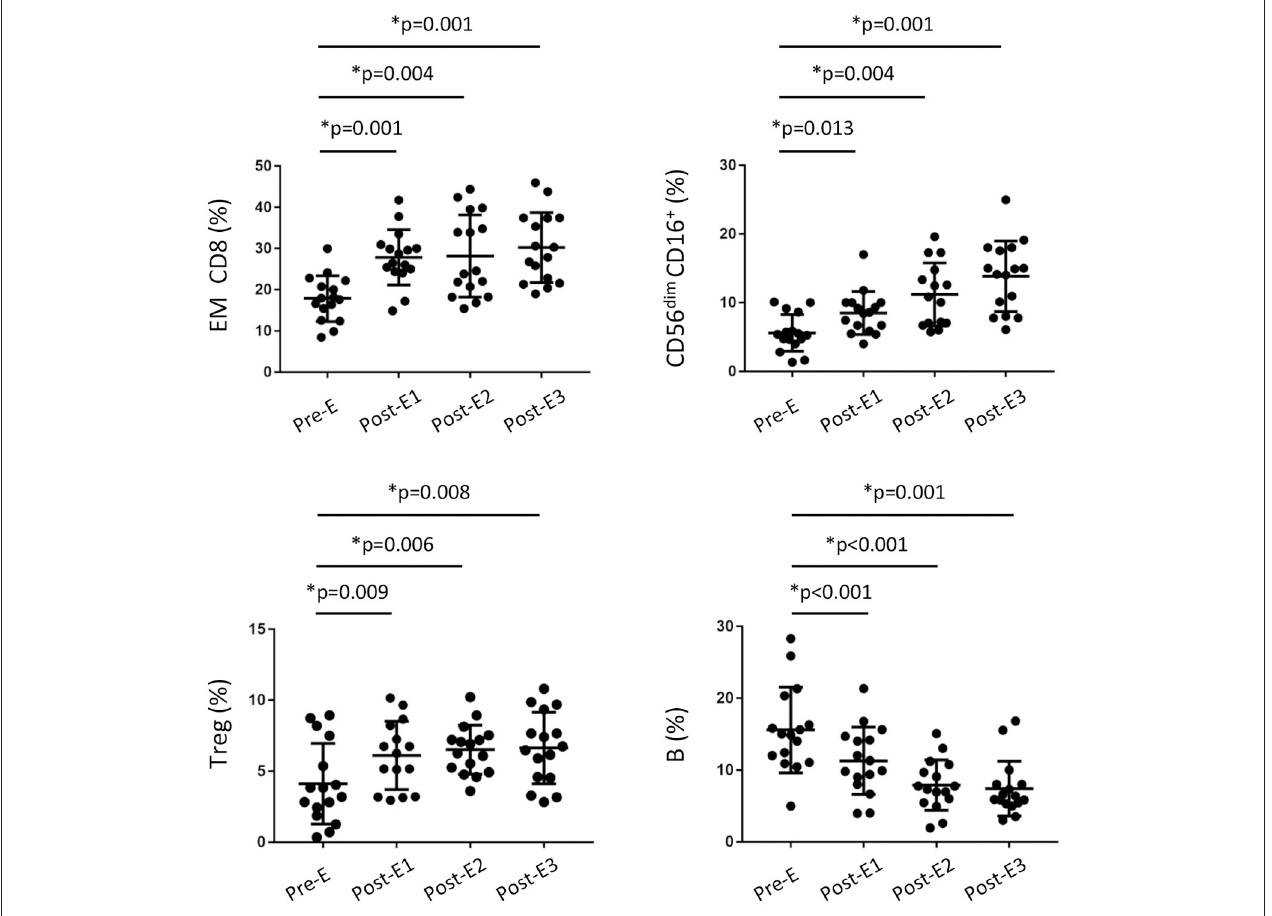
FIGURE 5 | Changes in the immune phenotype of HT patients during the first year post-transplant from the prospective study . Distribution of CD8 + T, regulatory T, NK and B cells in peripheral blood from HT patients ( n = 16) under EVL treatment from the third month post-transplant and follow-up at different times during the first year; before EVL initiation (Pre-E), and 1, 3, and 9 months after EVL conversion (Pre-E1, Pre-E2, Post-E3). Each circle represents one HT patient, and the mean and standard deviation are depicted as black bars. Differences between Pre-E and each time after EVL conversion (Post-E1, Post-E2 and Post-E3) were analyzed by the Wilcoxon test and * p <